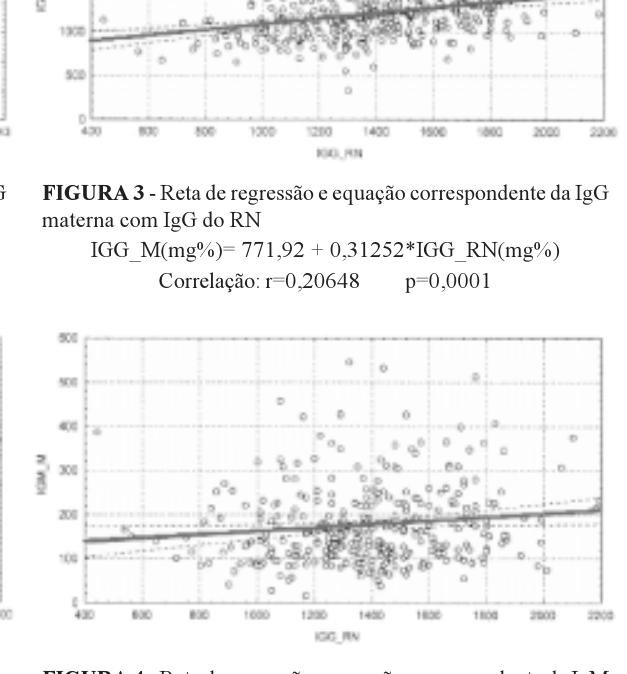
FIGURA 4 - Reta de regressªo e equa(cid:231)ªo correspondente da IgM